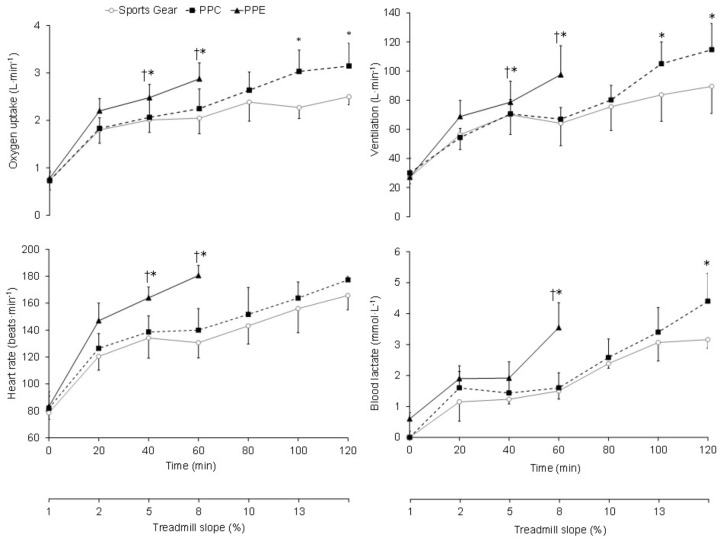
Comparative responses of oxygen uptake, ventilation, heart rate (HR), and blood lactate concentration wearing the short sports gear, the personal protective clothing (PPC) and the personal protective equipment (PPE) during the 120 min graded test. Values are mean ± SD. †Differences with PPC (p < 0.05). ∗Differences with sports gear (p < 0.05).